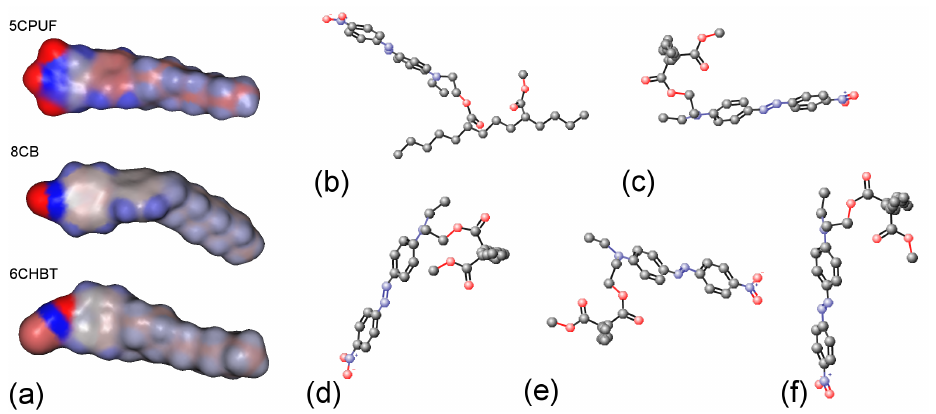
Figure 7. ( a ) Molecular electrostatic potentials (MESPs, blue is positive, red is negative) mapped for 5CPUF, 8CB and 6CHBT molecules; ( b – f ) some examples of various conformers of a pDR1